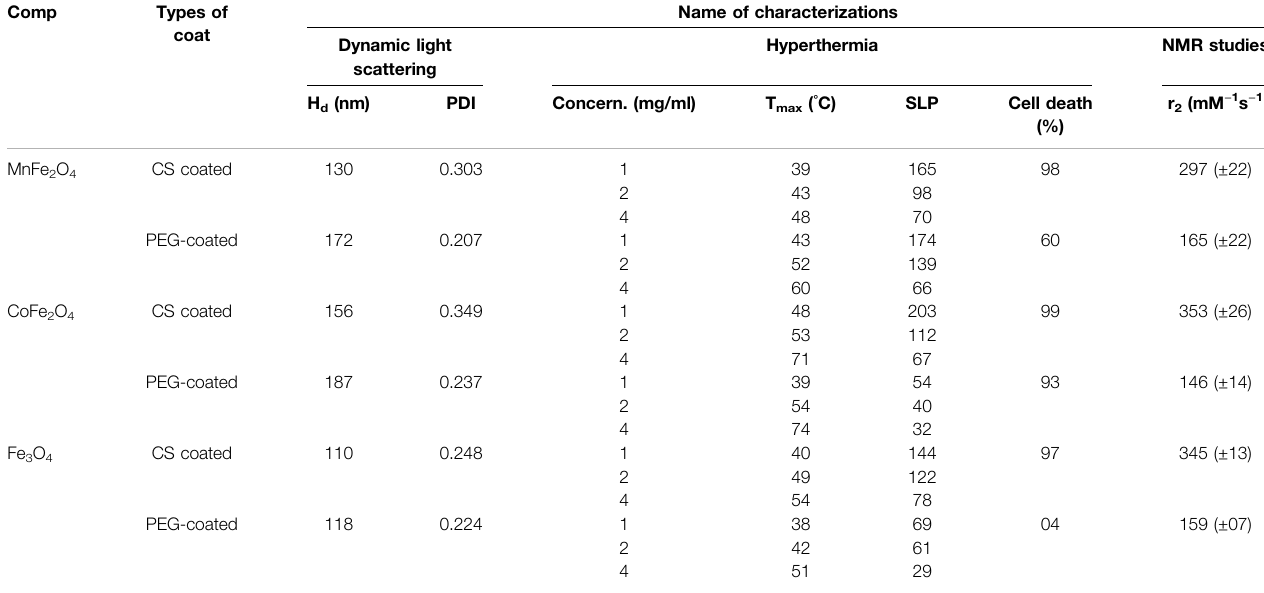
Inthetable,hydrodynamicdiameter(H d ),polydispersityindex(PDI)obtainedfromtheDLSmeasurementsarepresented.Maximumsaturationtemperature(T max )attainedbythechitosan and PEG-coatednanoparticles,speci fi closspower(SLP), and celldeaths of9 Lgliosarcomacancer cellsinhyperthermia studiesand therelaxivities(r 2 )extractedfromthe NMRstudies are presented.